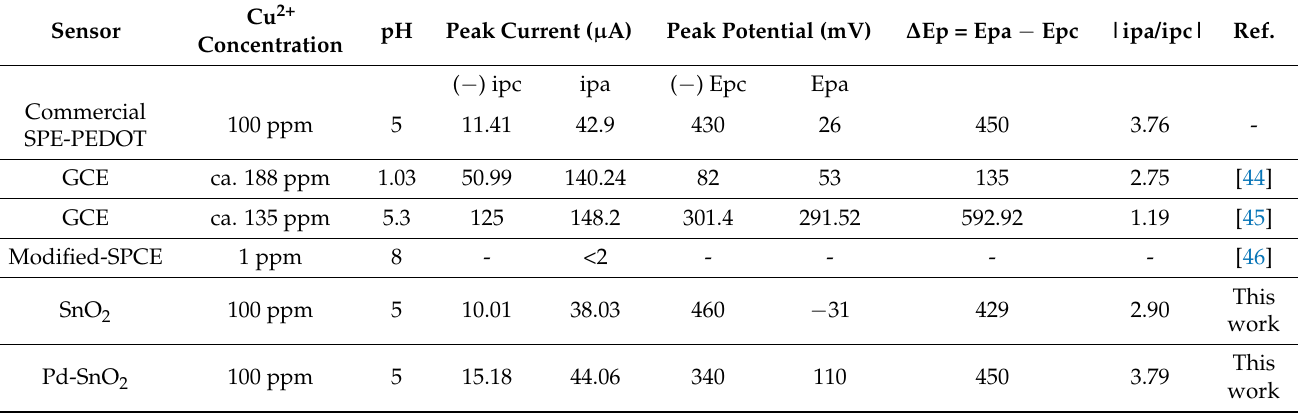
Table 4. Data obtained from voltammograms recorded for Cu 2+ in acetate buffer on different SnO 2 and Pd-SnO 2 based